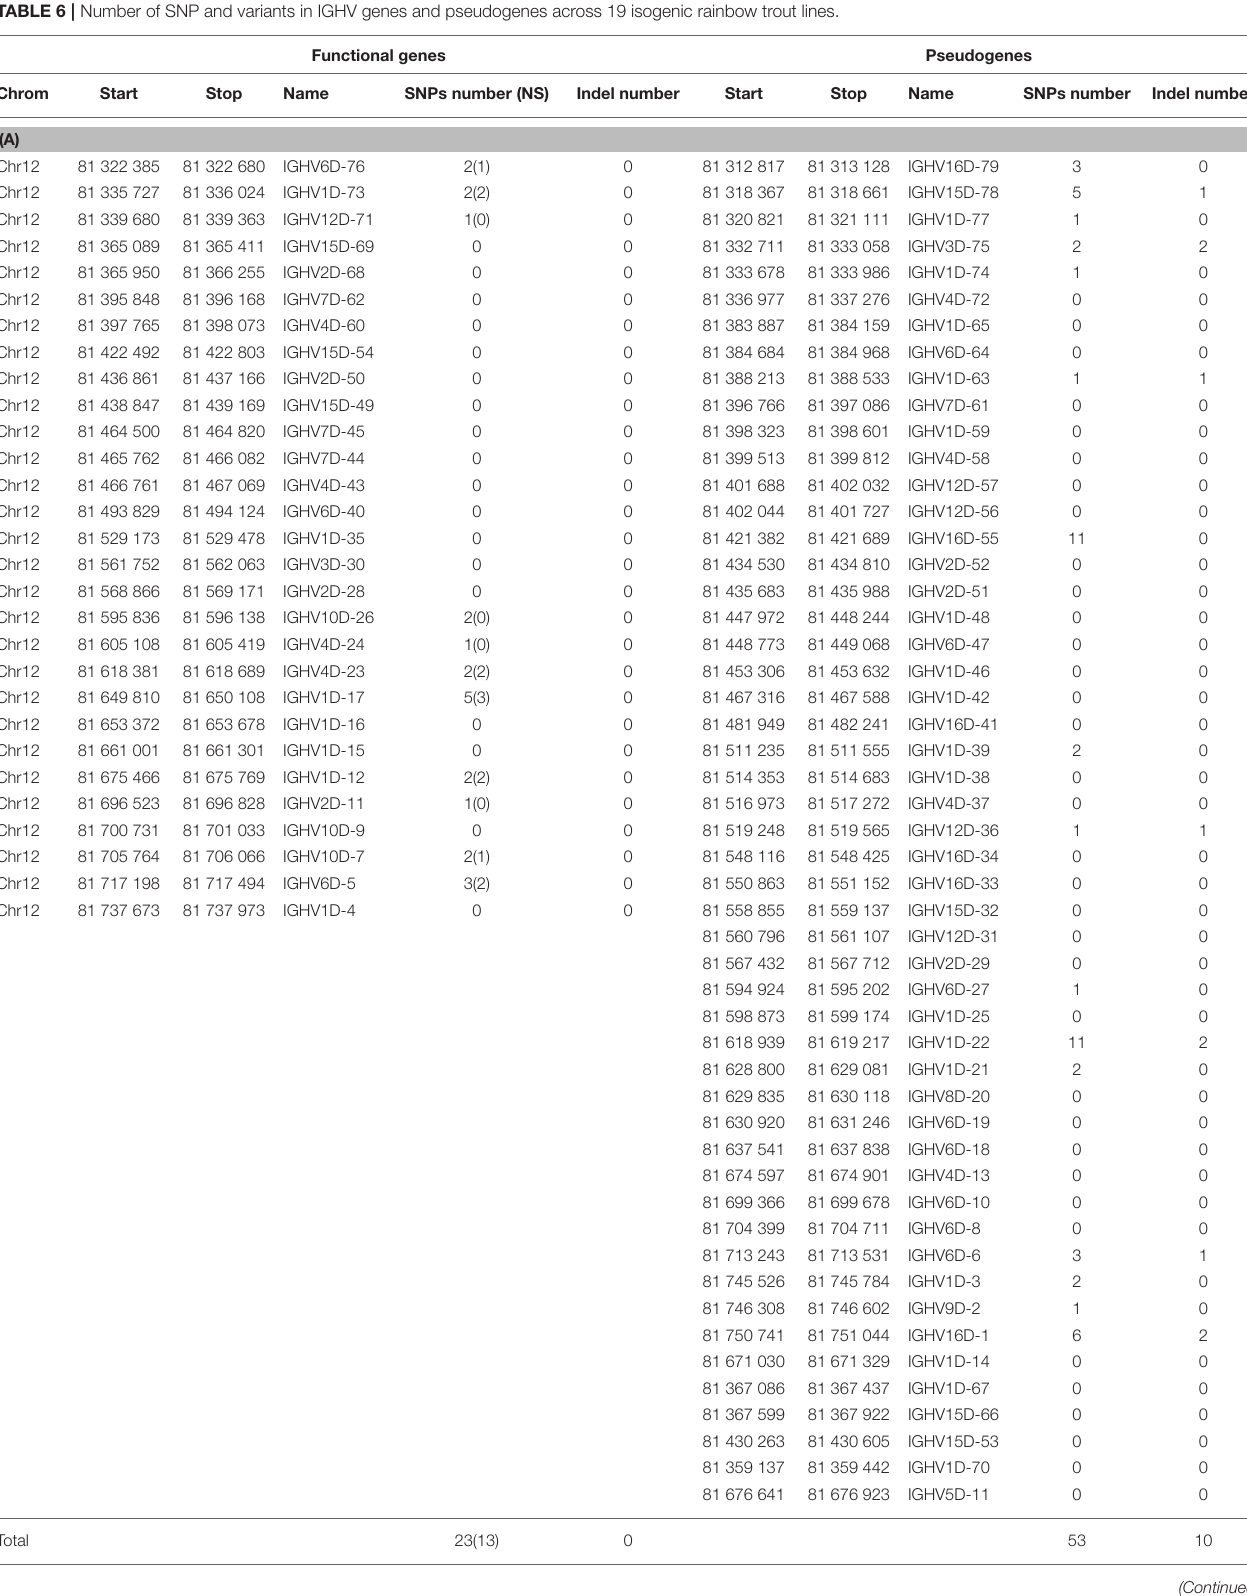
TABLE 6 | Number of SNP and variants in IGHV genes and pseudogenes across 19 isogenic rainbow trout